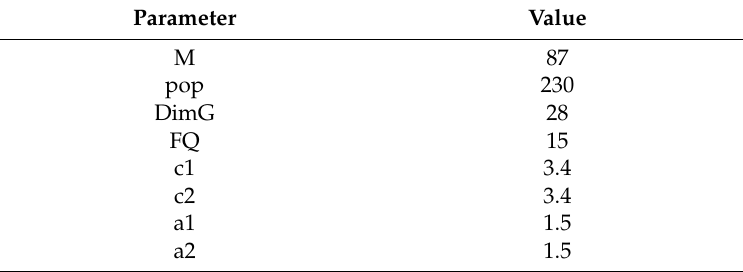
Table 8. Parameters of the best experiment with trapezoidal membership functions.